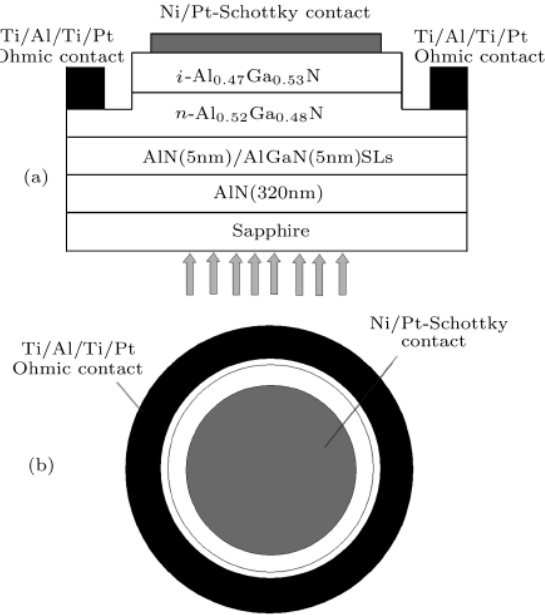
Figure 4. ( a ) Structure of Schottky-type back-illuminated photodetectors; ( b ) plan view of the contacts. (Reprinted from Reference